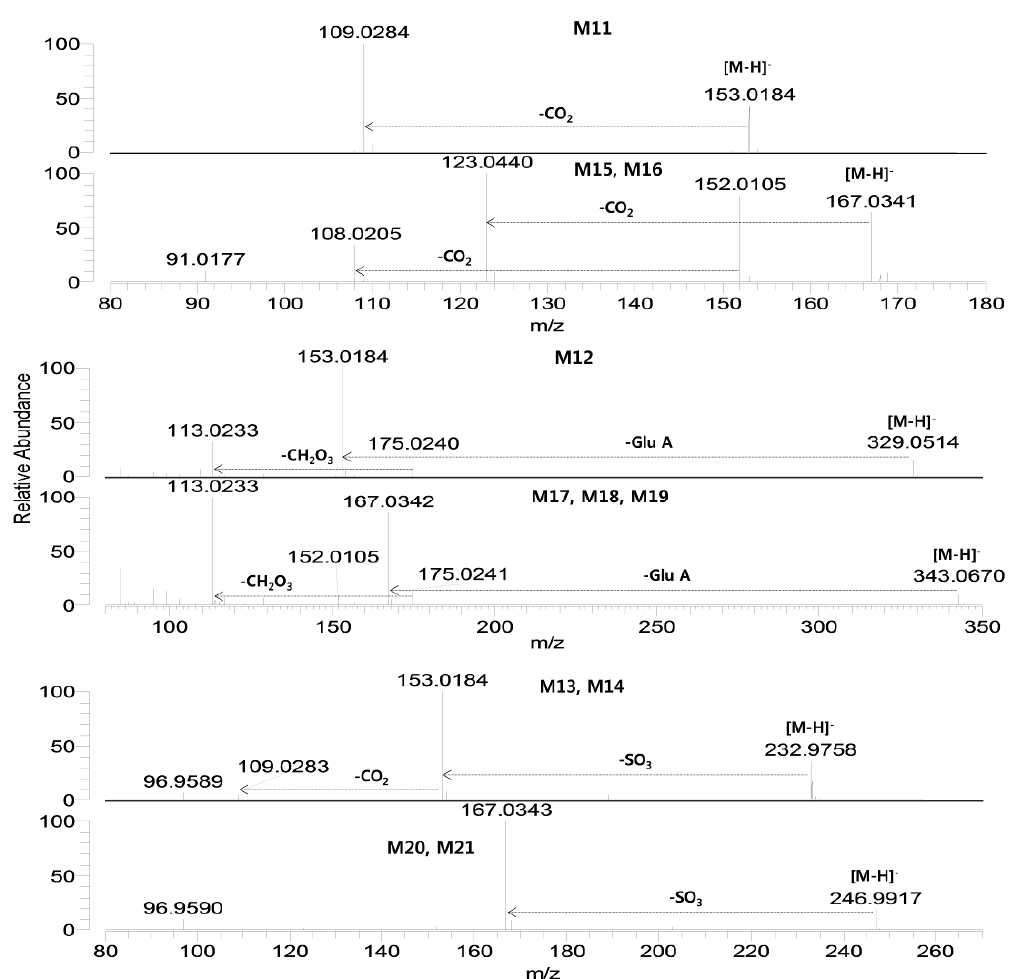
Figure 4. Product scan spectra of verproside and its metabolites (M11–M21) obtained by LC-HRMS analysis of the rat urine and bile samples obtained after intravenous administration of verproside at a dose of 10 mg/kg to a Sprague Dawley rat. Glc: glucose; Glu.A: